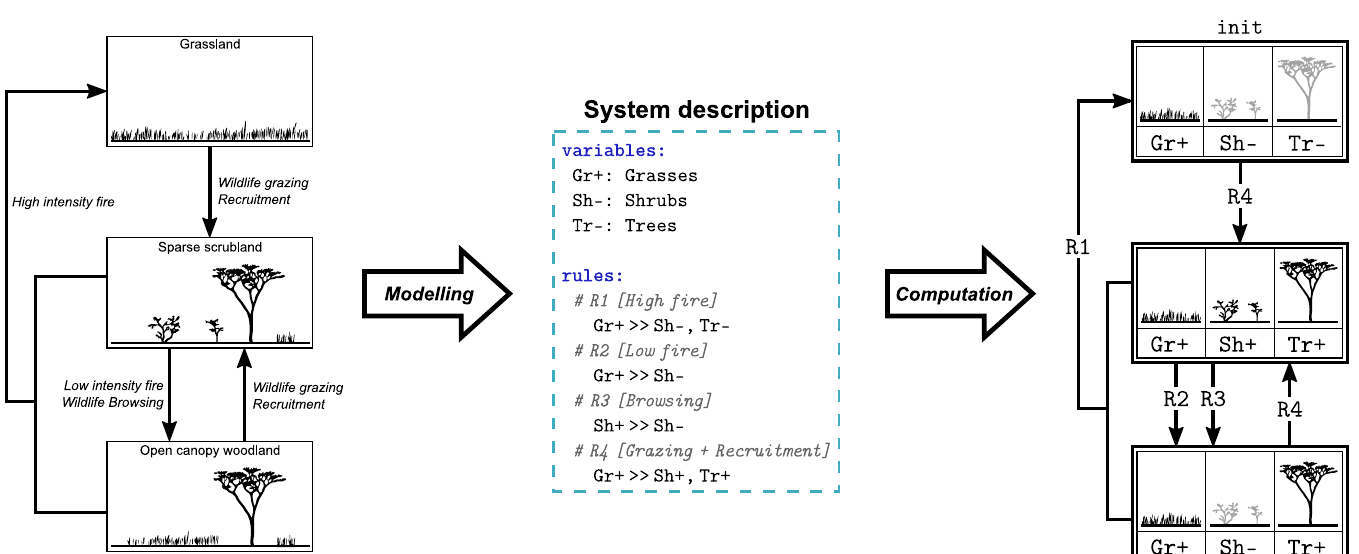
Fig 2. Toy model illustrating the if-then rule modelling. Modelling of the STM of Fig 1a (left) into a if-then rule model (middle: system description) from which an STG can be computed (right). Each state of the STG is a vector of three Boolean variables defined in the “ variables ” section of the system description: grasses ( Gr ), shrubs ( Sh ) and trees ( Tr ), noted with + if present and with - if absent. The initial values of the variables are noted next to their symbol in the system description, defining the initial state from which the STG is computed ( Gr+,Sh-,Tr- ). The “ rules ” section of the system description defines the if-then rules describing the transitions. For example, the first rule R1 embodies that if grasses are present ( Gr+ ) then ( >> ) they can fuel a high intensity fire burning down shrubs and trees ( Sh-, Tr- ), as grasses resprout first they do not disappear in the fire consequence. This rule corresponds in the STG to the transitions labelled by R1 from the middle and bottom states toward the top state. The cascading applications of every rule whose condition is fulfilled and whose consequence is not to every reachable state compute the STG. Compared to the STM, the computed STG is more explicit: there are two transitions from the middle state toward the bottom one because two distinct events may lead the system from the former to the latter.